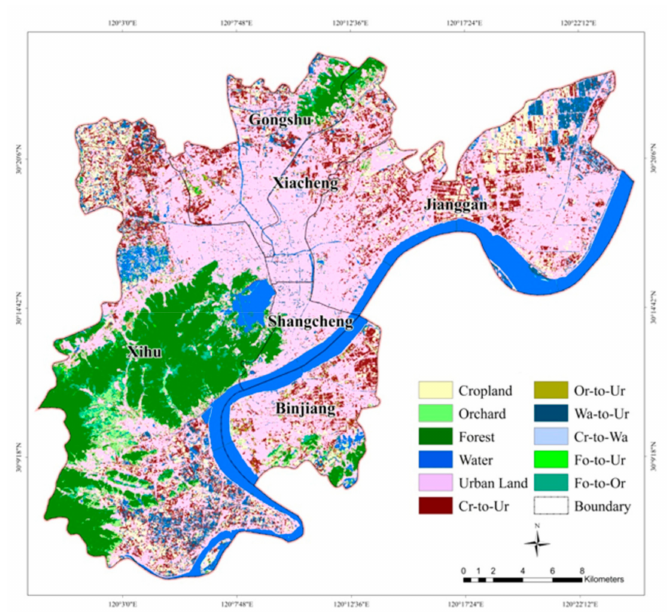
Figure 7. Result of land use and land use changes, 2006–2016.